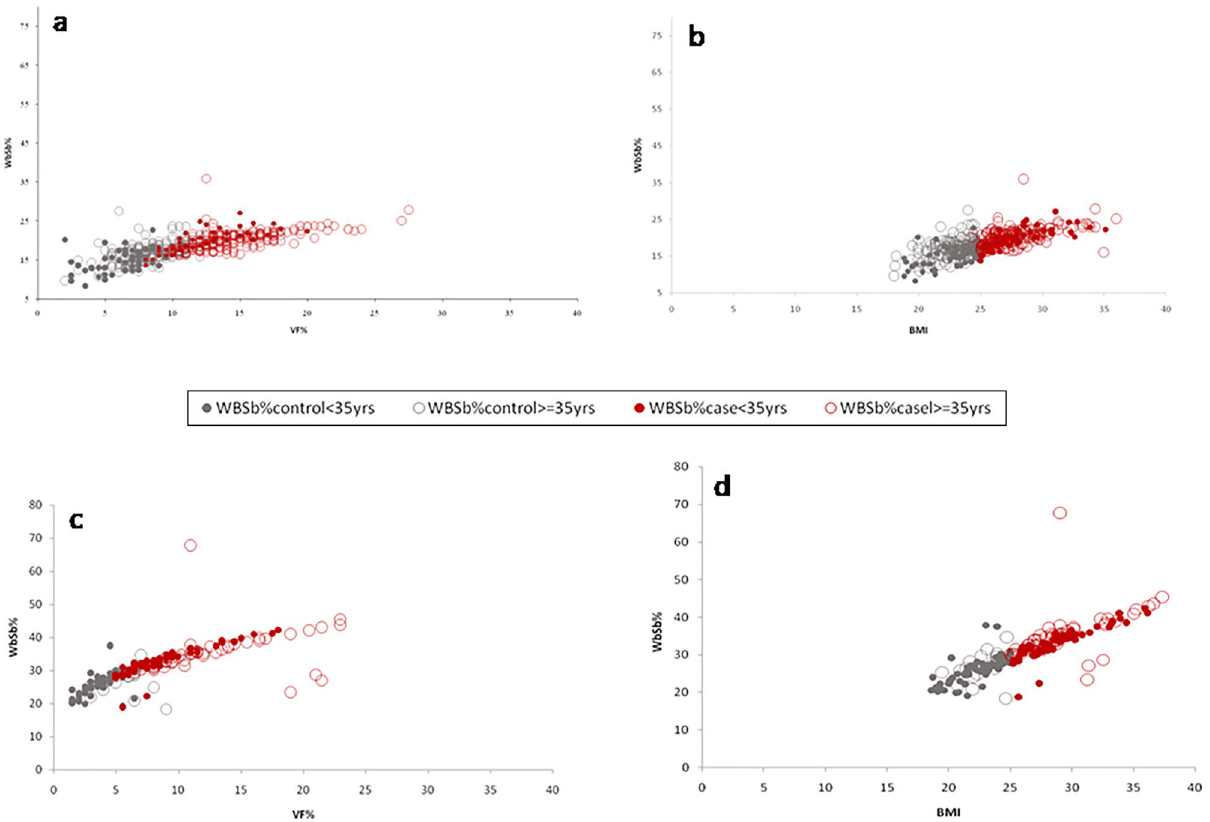
Figure 1. Association between (i) VF% and WbSb% ( a & c ) (ii) BMI and WbSb% ( b & d ) in the total male and female population